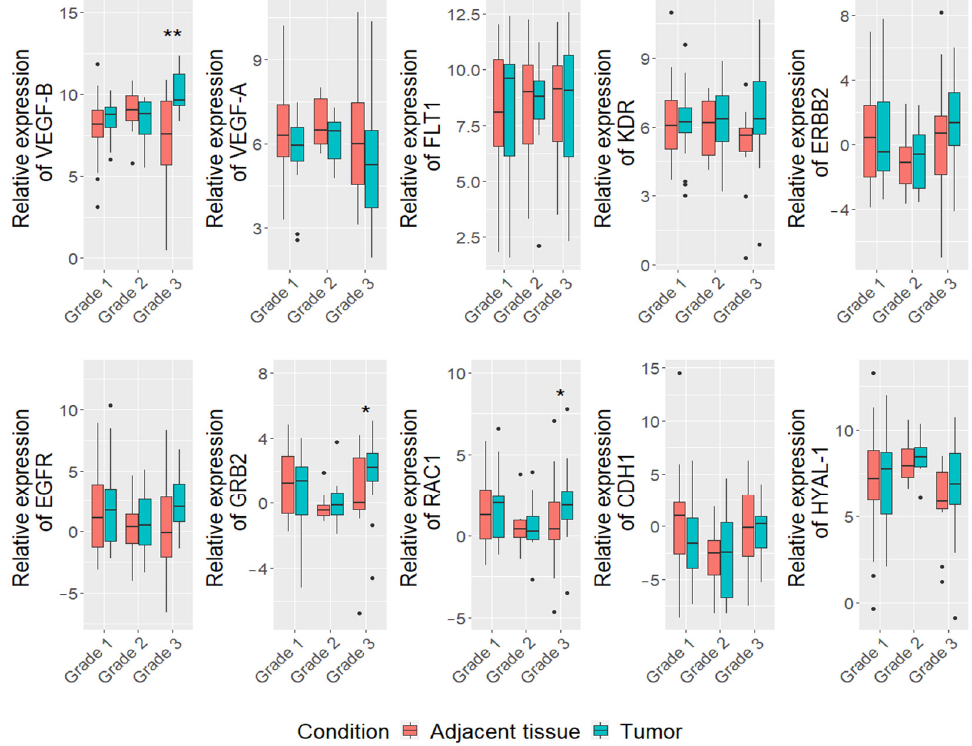
Figure 2. Expression levels of 10 analyzed ) in CMTs and tumor adjacent tissues in different grade carcinomas. Dots indicate outliers. * p < 0.05, ** p < 0.01 measured with Wilcoxon or t -tests.